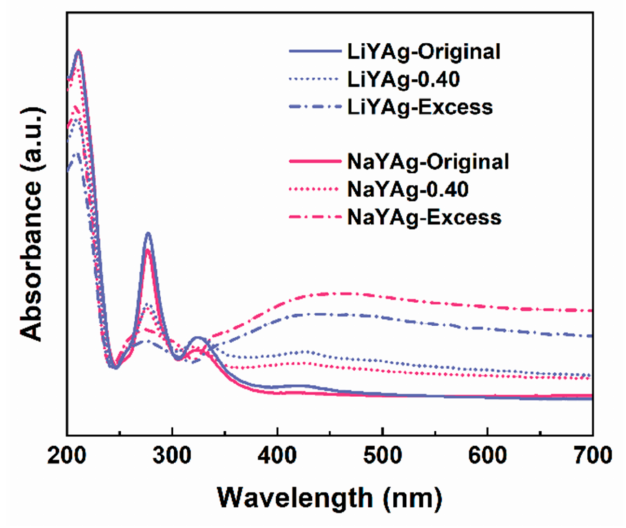
Figure 5. UV–vis absorbance spectra of LiYAg and NaYAg before and after exposing in different formaldehyde atmospheres.